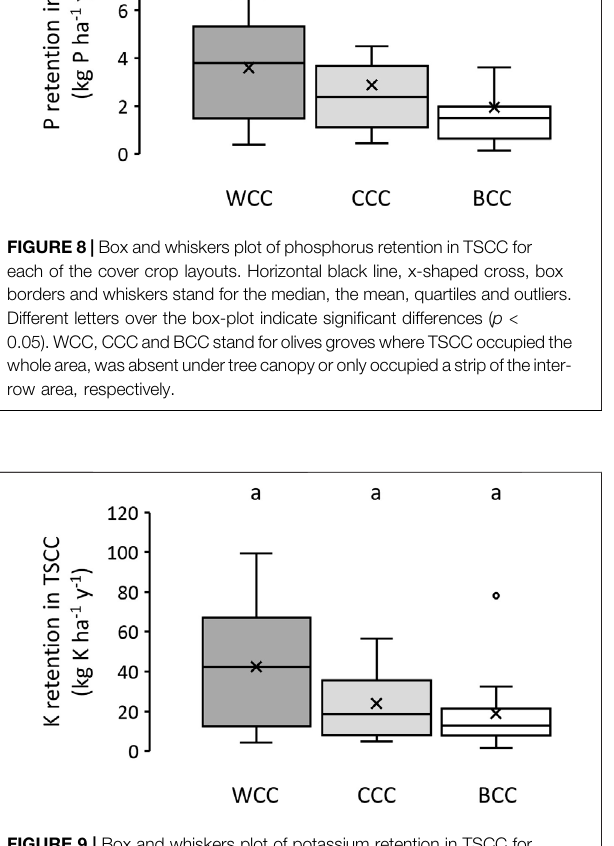
( Supplementary Figure S2 ). As expected, differences between tree densities or TSCC layouts were not signi fi cant but averages were higher for BCC (2.13%) than for WCC and CCC (1.71 % and 1.76%, respectively).